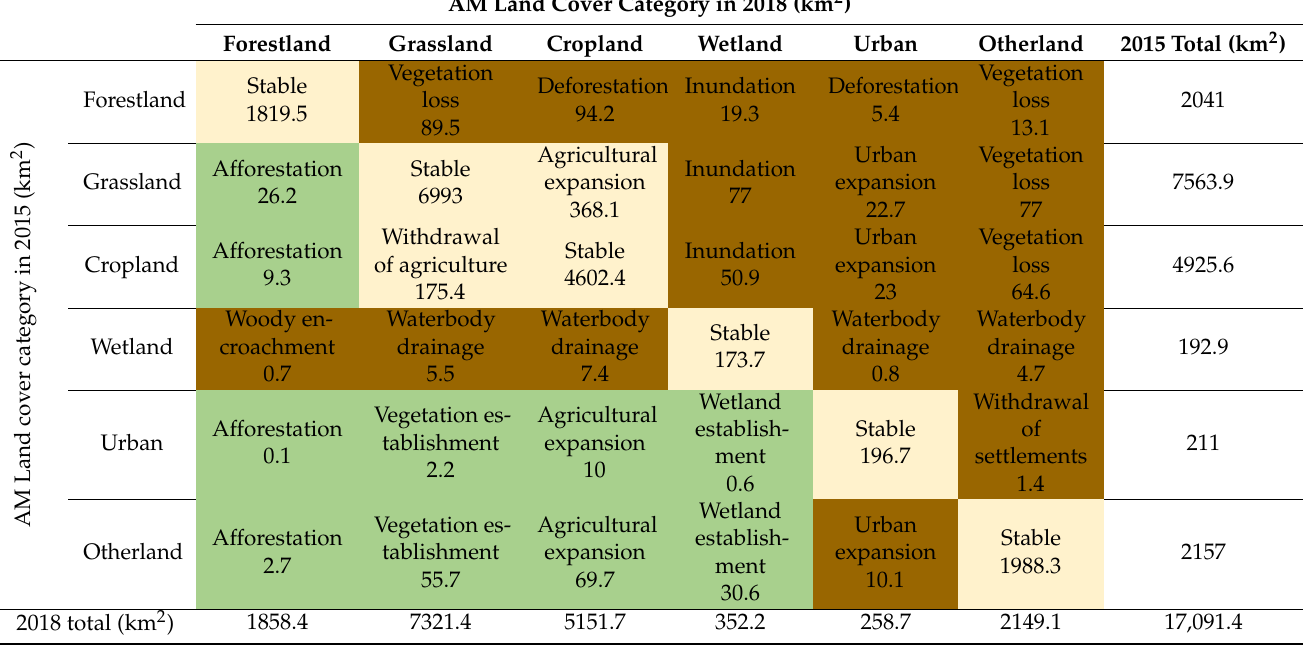
Table A2. Land cover transition matrix in km 2 (2015–2018) based on the adapted methods (AM). Green, beige and brown colors indicate improvement, stable and decline of land cover category, respectively. The area and the possible cause of the land cover transition are indicated in the matrix. The change is based on the high-resolution land cover